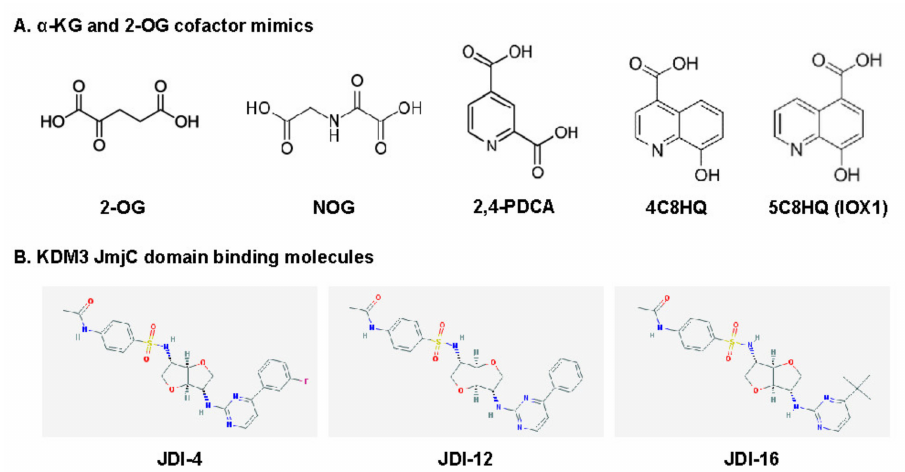
Figure 3. Chemical structures of KDM3 inhibitors and modulators: (a) cofactor mimics; (b) KDM3 JmjC domain-binding